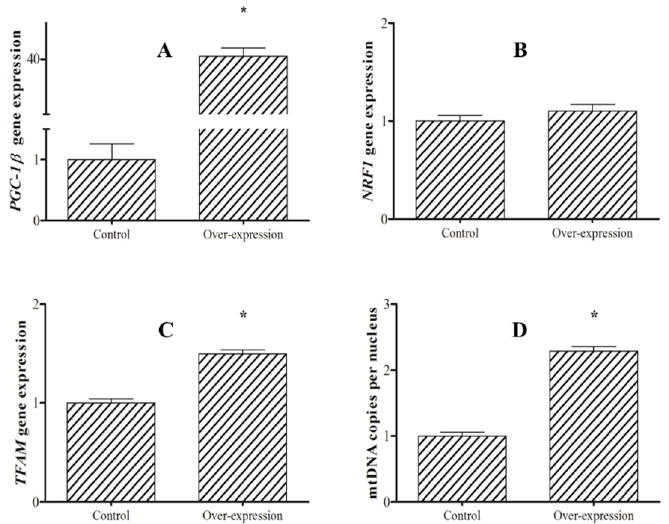
Figure 4. Expression of PGC-1 β ( A ), NRF1( B ) and mitochondrial transcription factor A (TFAM) ( C ); and mtDNA ( D ) copies after overexpression of PGC-1 β in hepatocytes of blunt snout bream ( M. amblycephala ). The asterisk indicates significant difference ( P < 0.05, Student’s t-test).